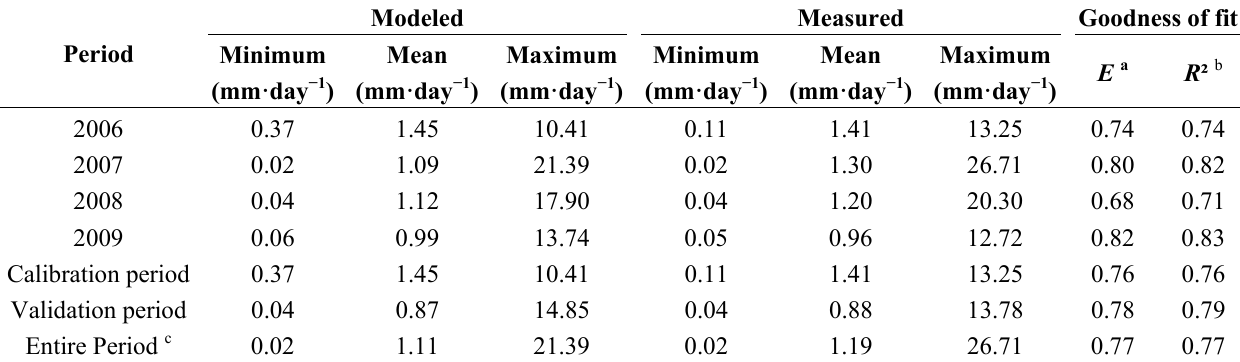
Table 3. Summary of measured and modeled, annual and seasonal streamflow statistics and goodness-of-fit measures for Salmon Creek watershed. The calibration and validation periods range from 22 July 2006–21 July 2008 and 22 July 2008–31 December 2009,